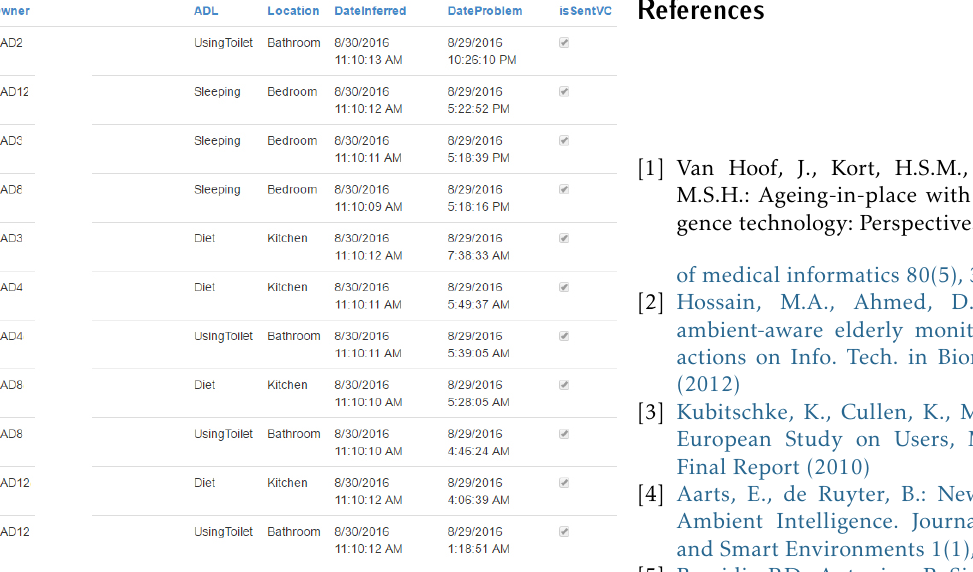
Figure 5. A screenshot of inferred problems.